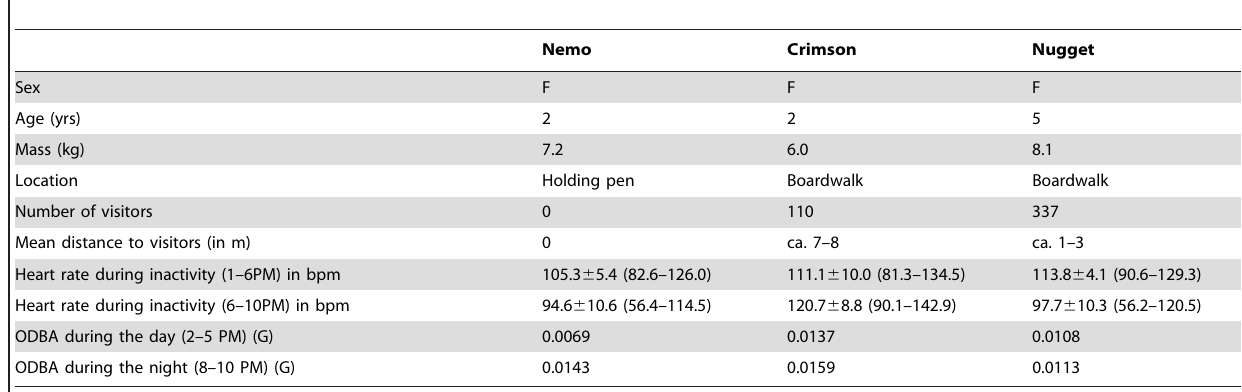
Table 1. Summary of freely-living koalas used at the Koala Conservation Center, Phillip Island, Australia. Heart rate values are given as means 6 1SD, and the range is indicated in